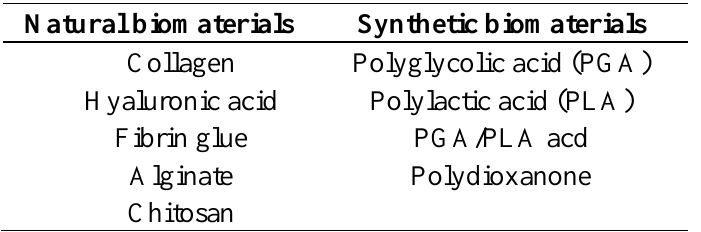
Table 1. Scaffold biomaterials available for clinical application of cartilage tissue